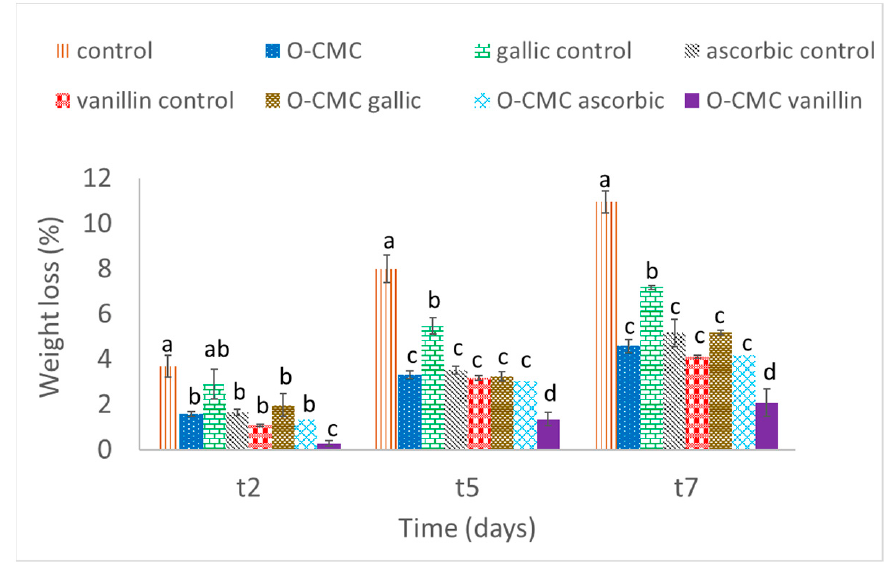
Figure 1. Weight loss (%) of fresh-cut strawberries treated with oligo-CMC formulations after 2, 5, and 7 days of storage at 4 °C (t2, t5, and t7, respectively) as the means of 5 fruit cuts. Values followed by a different letter within the same sampling time are significantly different according to Tukey HSD test at p ≤ 0.05.